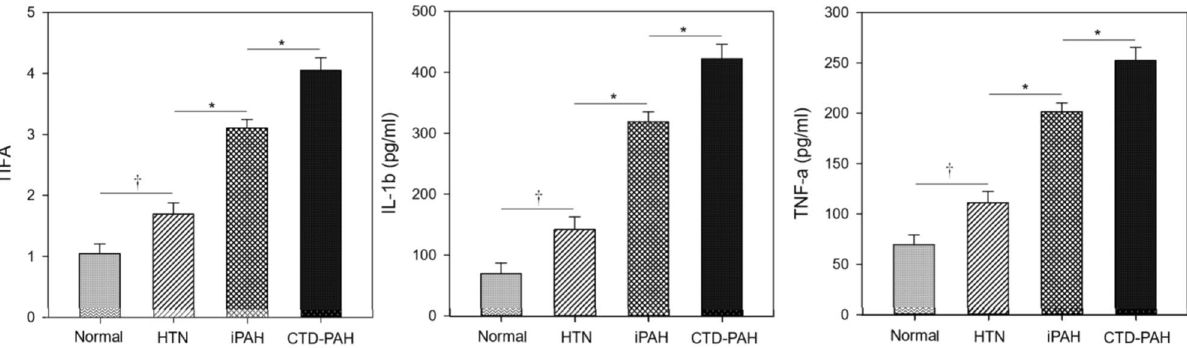
Figure 1. Generalized linear models of TIFA protein expression in PBMCs and plasma levels of IL-1β and TNF-α after adjusting for age, gender, and mean arterial pressure in normal controls, systemic hypertensive (HTN) subjects, patients with idiopathic pulmonary arterial hypertension (iPAH) (n = 32), and patients with connective tissue disease-associated PAH (CTD-PAH) (n = 16). Among all the four groups, patients with CTD- PAH had the highest expression of TIFA protein and plasma levels of IL-1β and TNF-α. Significant between- group differences could be observed in all the three inflammatory biomarkers. * P < 0.001; † P < 0.01; All values are expressed as mean ± standard error. IL-1β = interleukin-1β; TIFA = tumor necrosis factor-α receptor-associated factor-interacting protein with a forkhead-associated domain; TNF-α = tumor necrosis